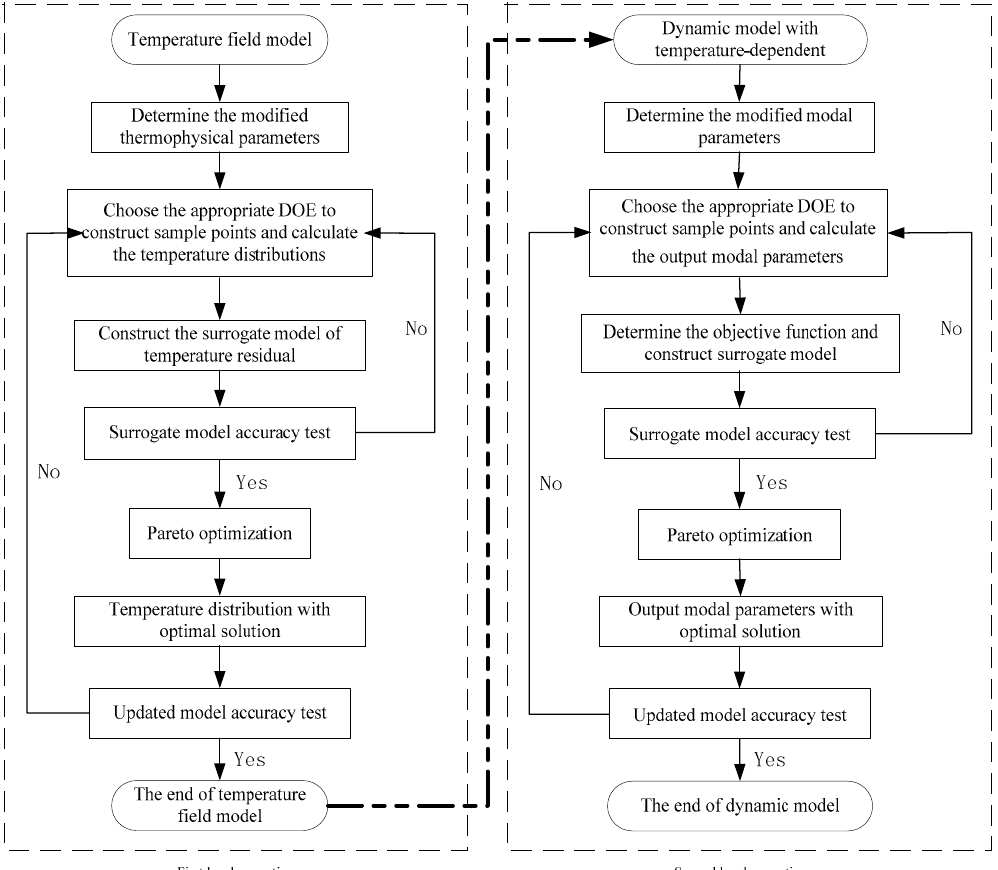
Figure 2. Flow chart of thermophysical parameter identification with temperature dependence.